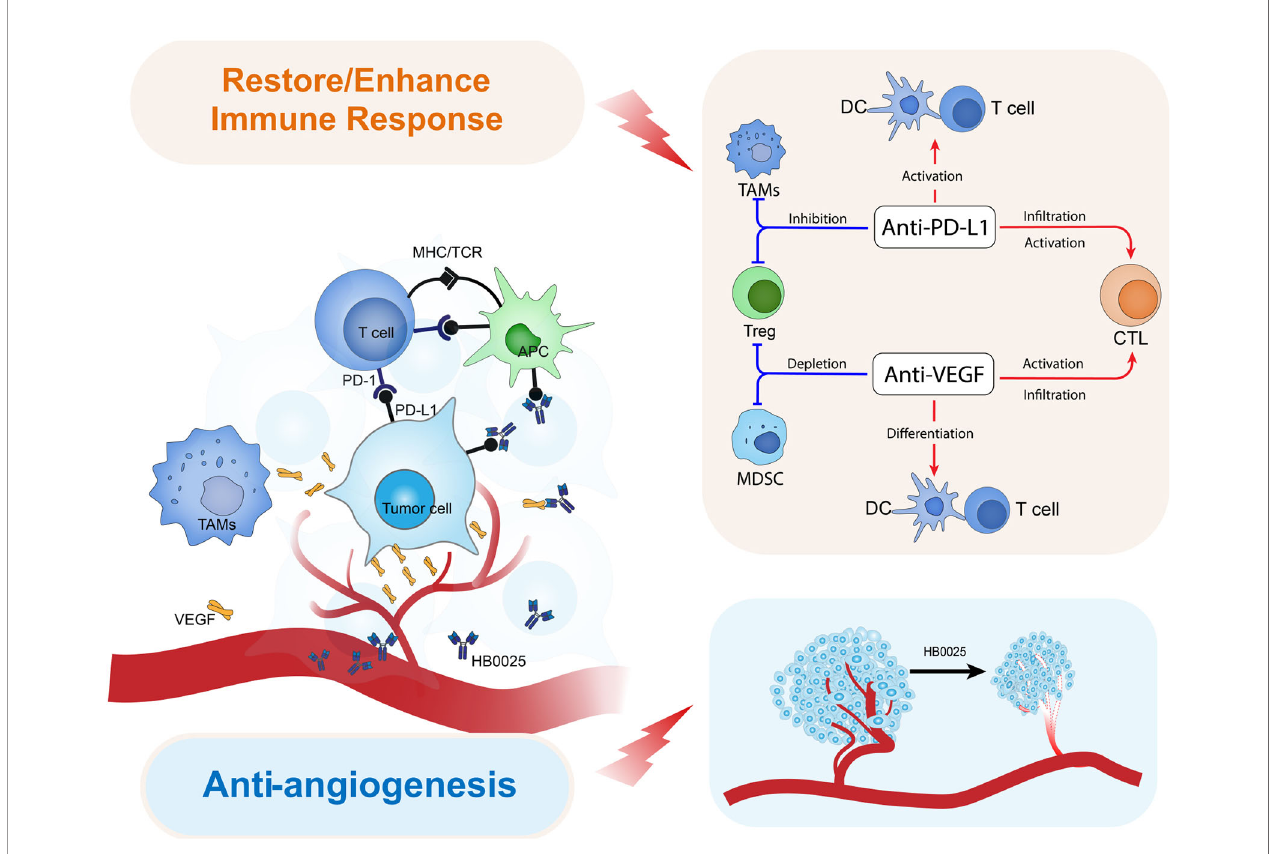
FIGURE 4 | Model diagram of HB0025 biological mechanism in vivo